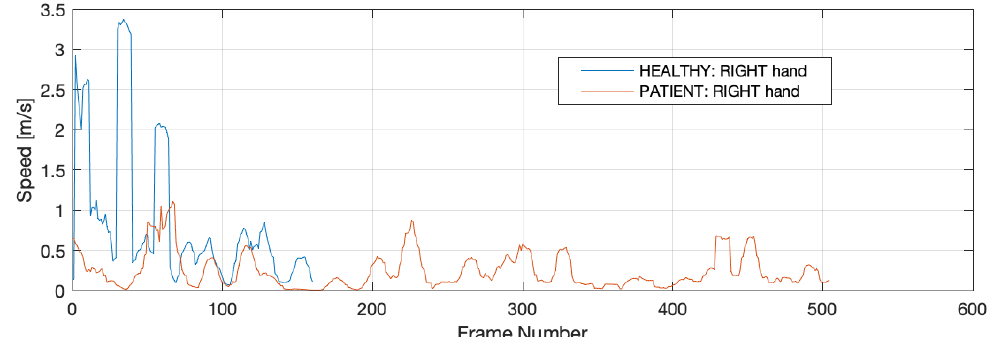
Figure 16. Example of speed comparison on the same test between a patient and a healthy tester.